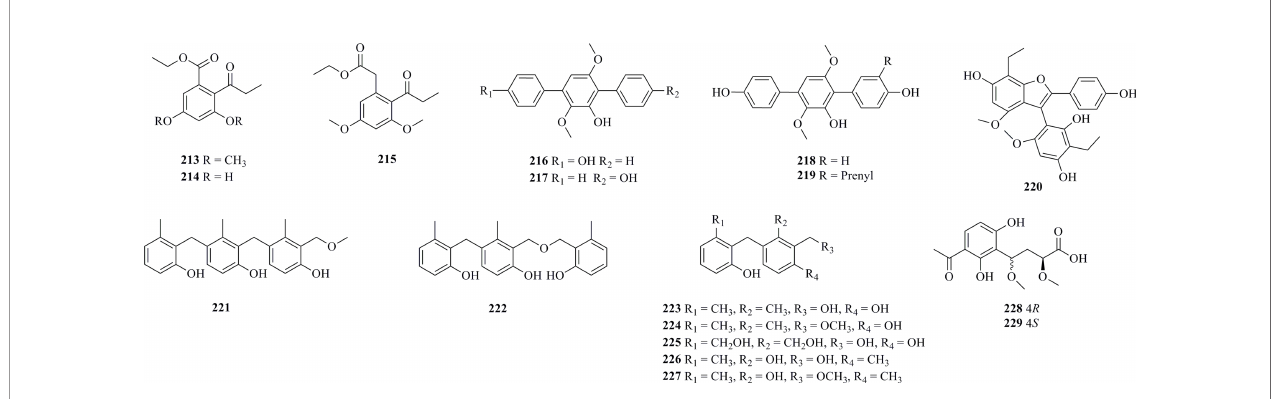
FIGURE 12 | Phenolic derivatives isolated from deep-sea fungi ( 213 − 229